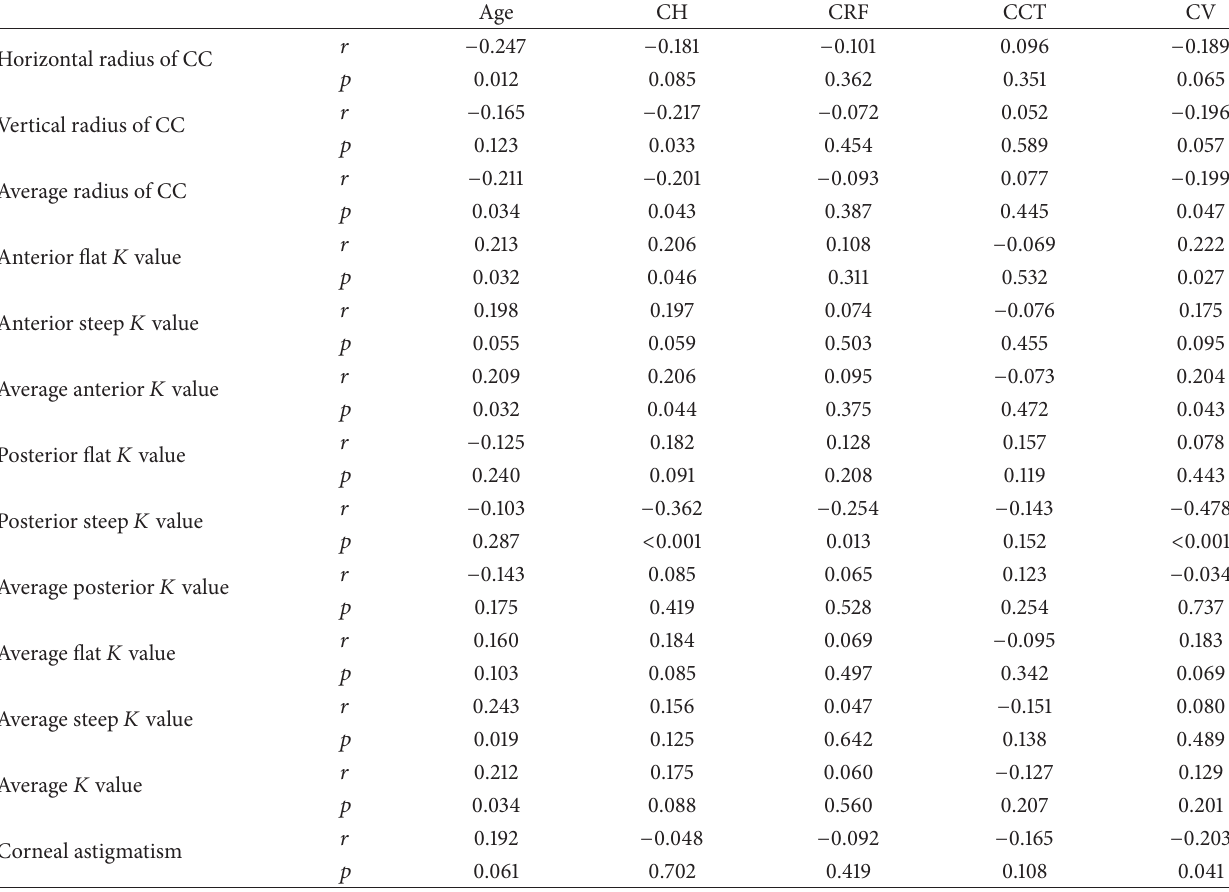
Table 4: The relationship of corneal biomechanical properties, age, CCT, and CV with keratometric values of anterior and posterior corneal surface.